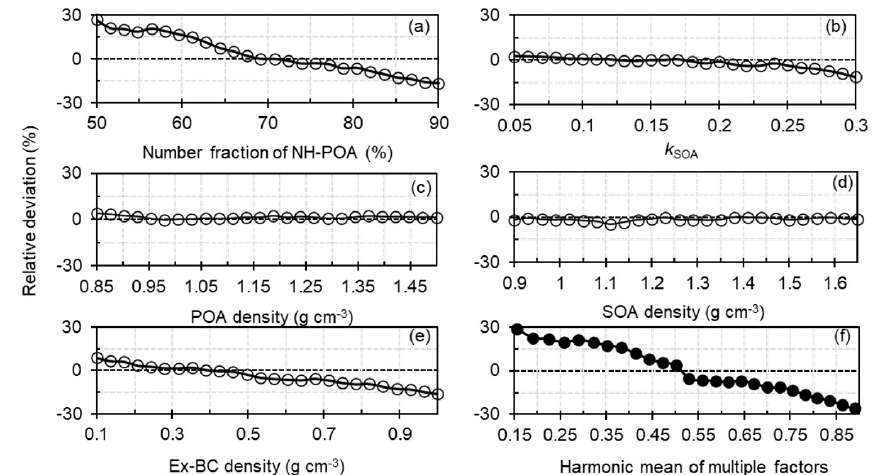
Figure 3. Relative deviations of the number fraction of nearly hydrophobic (NH) POA to the In-BC density (a) , the hygroscopic parameter of OA to the In-BC density (b) , the POA density to the In-BC density (c) , the SOA density to the In-BC density (d) , the externally mixed BC density to the In-BC density (e) , and the combined deviations based on multiple factors mentioned above (f)